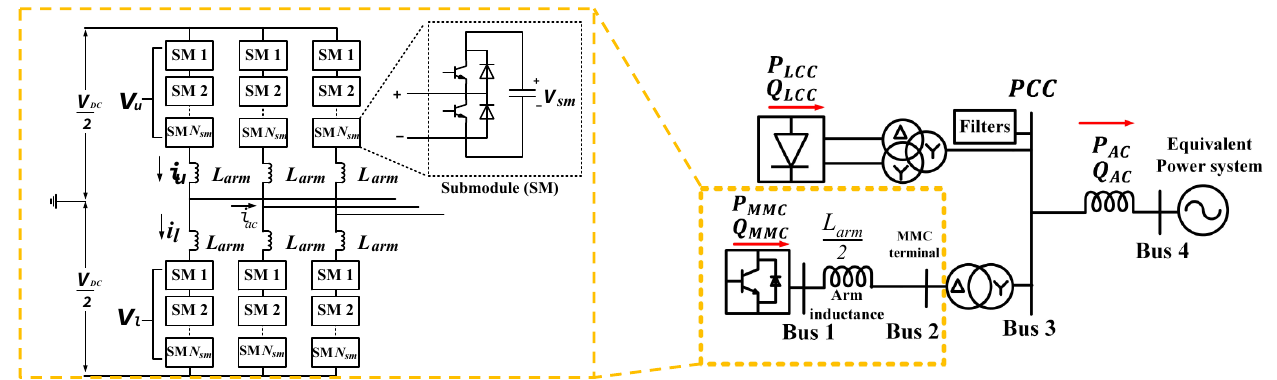
Figure 1. The overall circuit diagram of LCC and MMC-HVDC integrated into MILM system and the MMC structure.